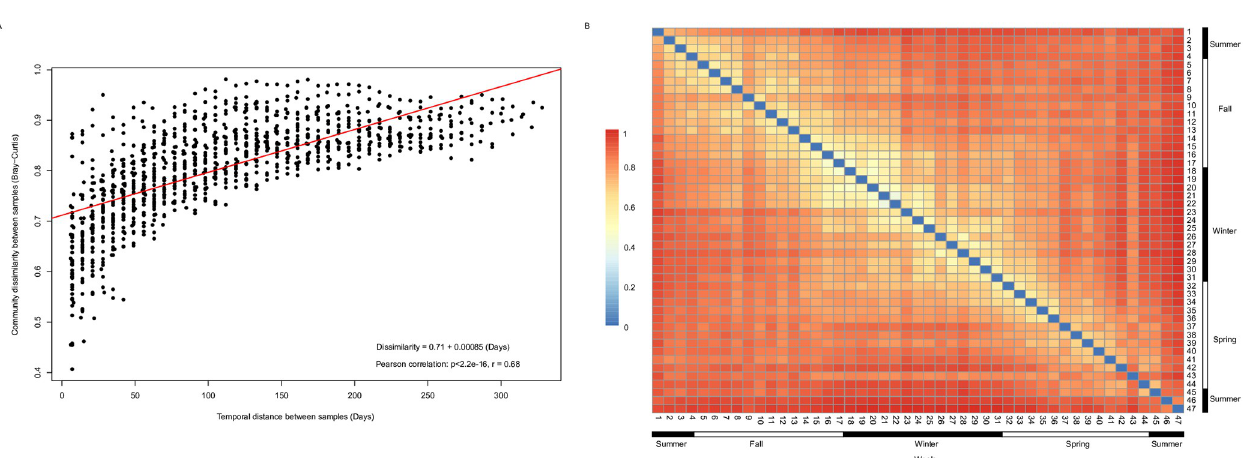
PLOS ONE | https://doi.org/10.1371/journal.pone.0267390 April 28,